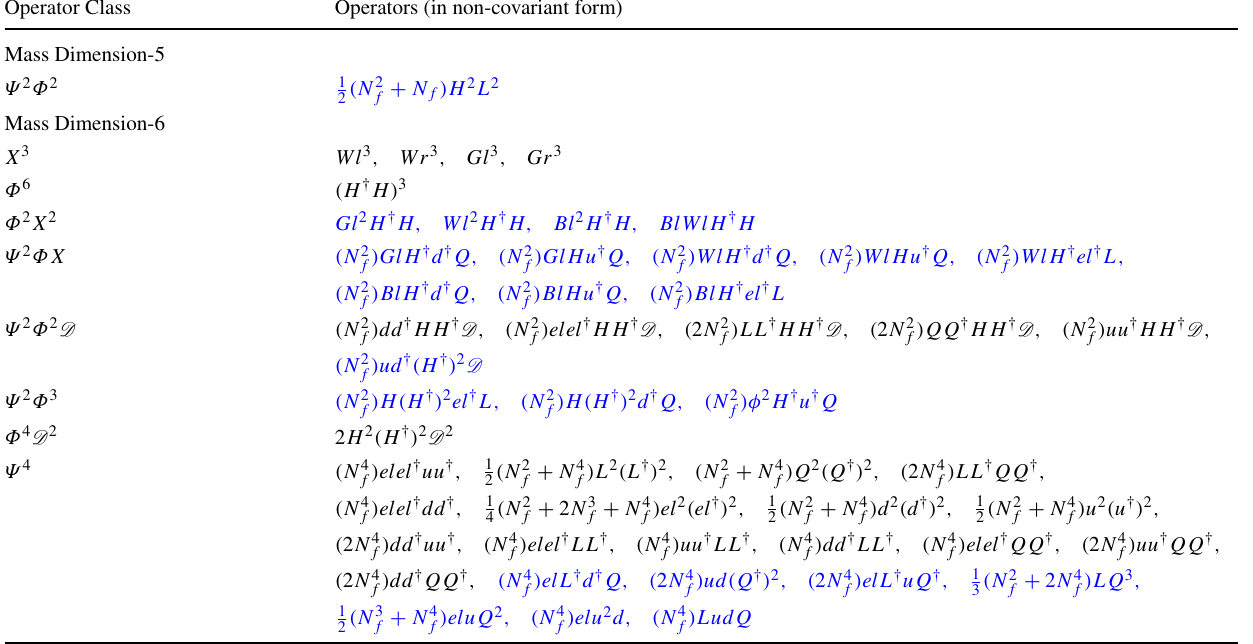
which are summed over with the suitable coupling constants. ♣ - In the Hilbert Series the fermion kinetic terms appear with a factor of N 2 but f in the physical Lagrangian there is a flavour symmetry which forces the kinetic terms to be diagonal and the factor of N 2 is reduced to N f . f For the gauge kinetic terms the translation from the form ( Fl , Fr ) to ( F μν , ˜ F μν ) is accomplished using Eq. (108) No. of Operators (including h.c.)